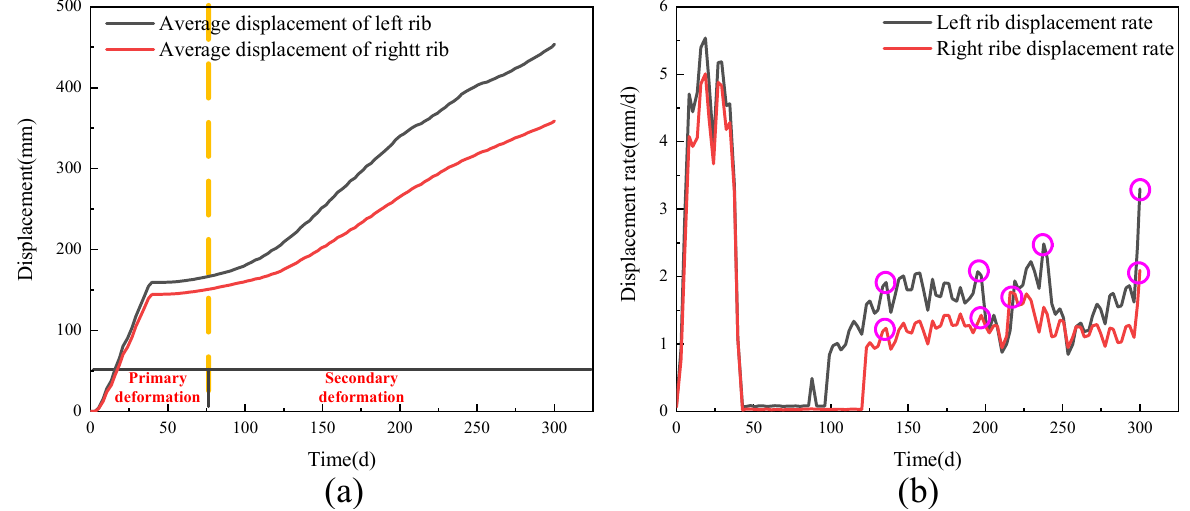
Figure 11. Average displacement and displacement rate of two ribs of roadway. ( a ) average displacement; ( b ) average displacement rate.